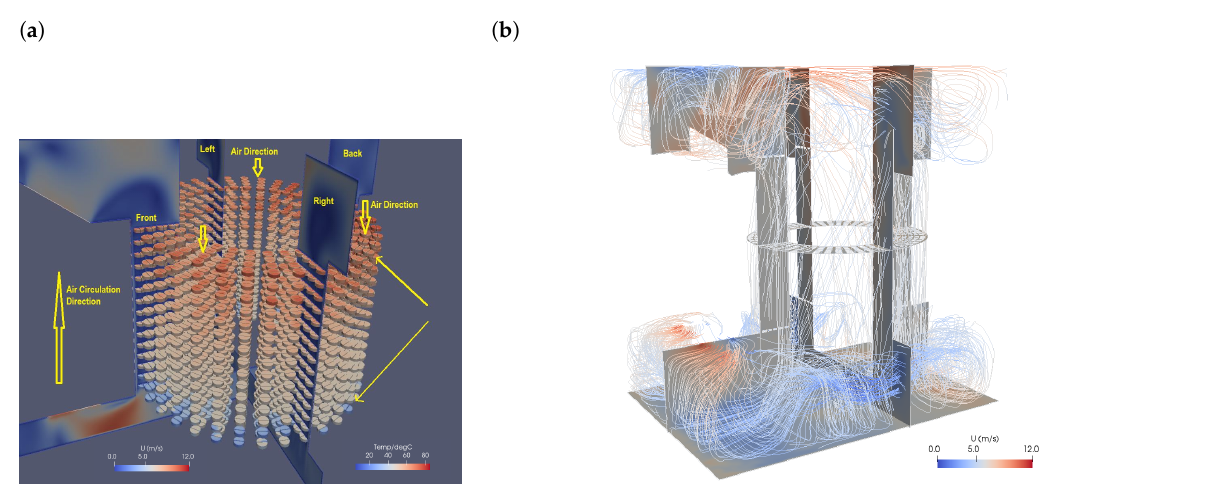
Figure 6. Flow field pattern visualization in the spiral for ( a ) the pasties distributed in the spiral and ( b ) the Streamlines which illustrate air flow behavior inside the spiral system. In ( a ) the surface temperature of the pasties is indicated by the right hand colour map; the flow speed on the cutting planes by the left hand colour ma; the same colour map being used on the streamlines for figure ( b